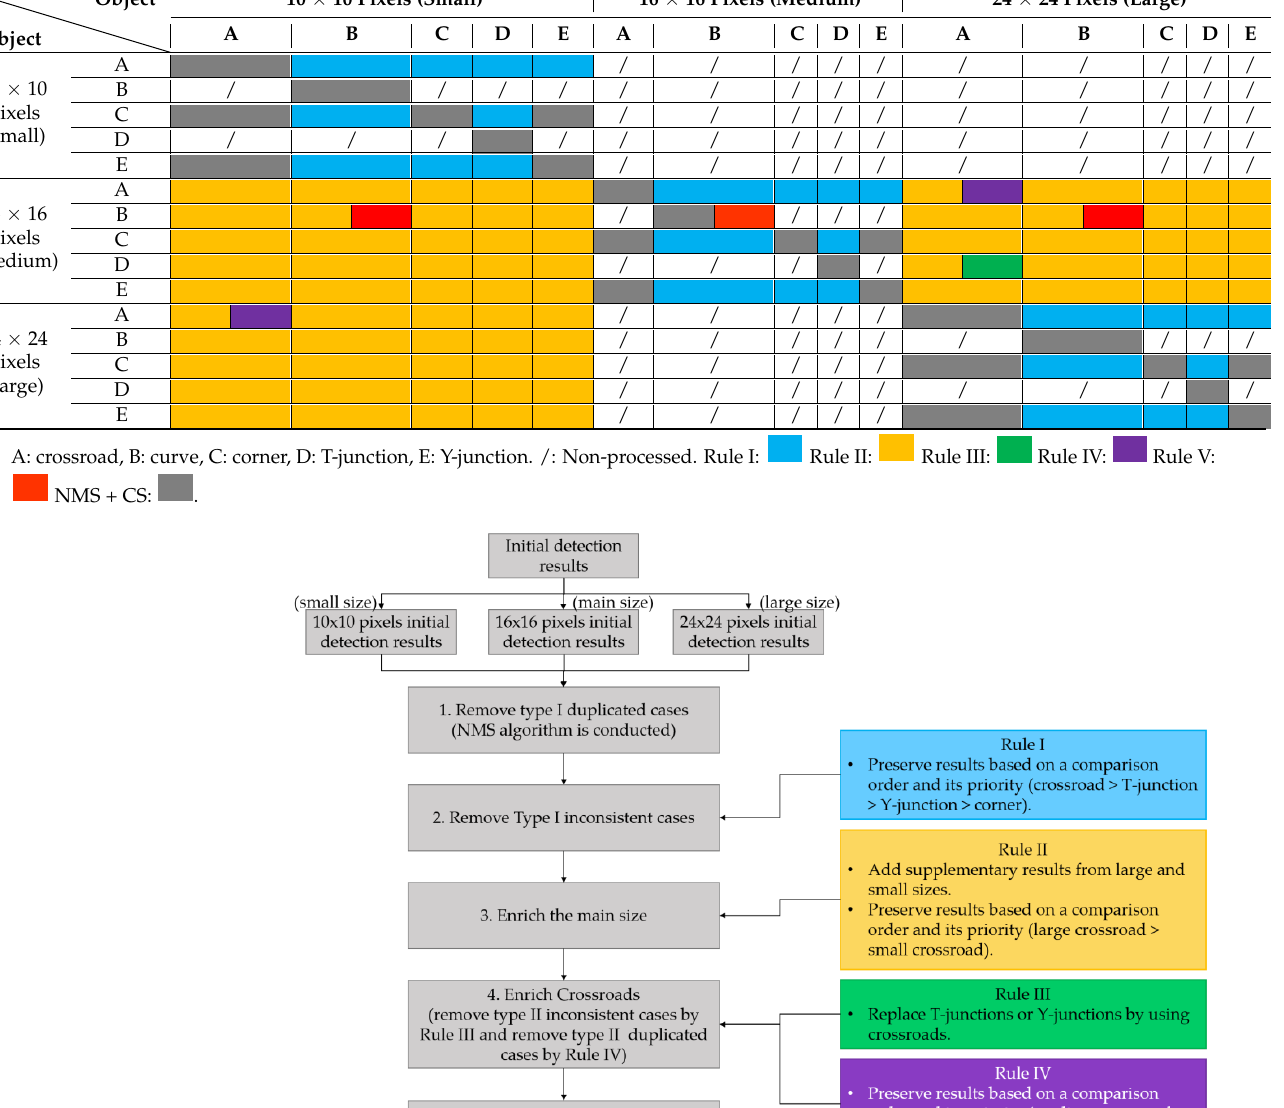
Table 1. Combination rules. Object